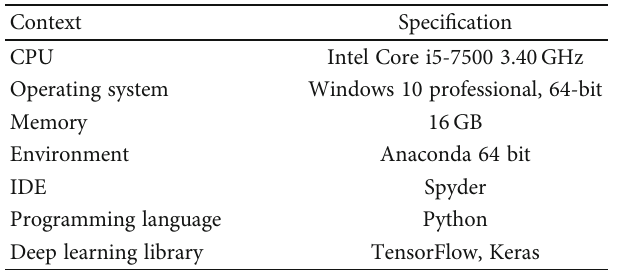
Table 1: Technical speci fi cation of the hardware and the development